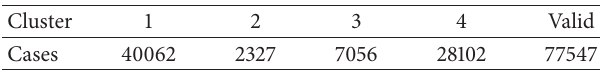
Table 6: Number of cases in each of the clusters (nonsurgical patients).